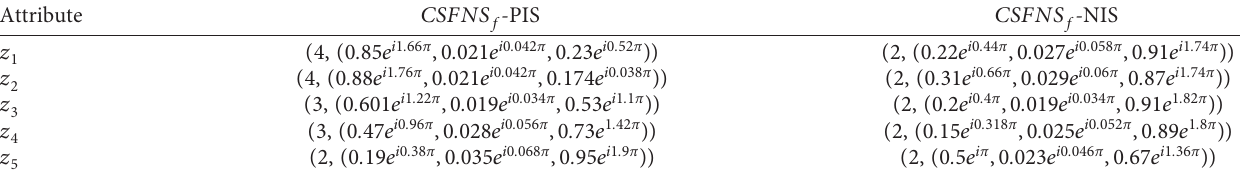
CSFNS f -PIS and f -NIS.